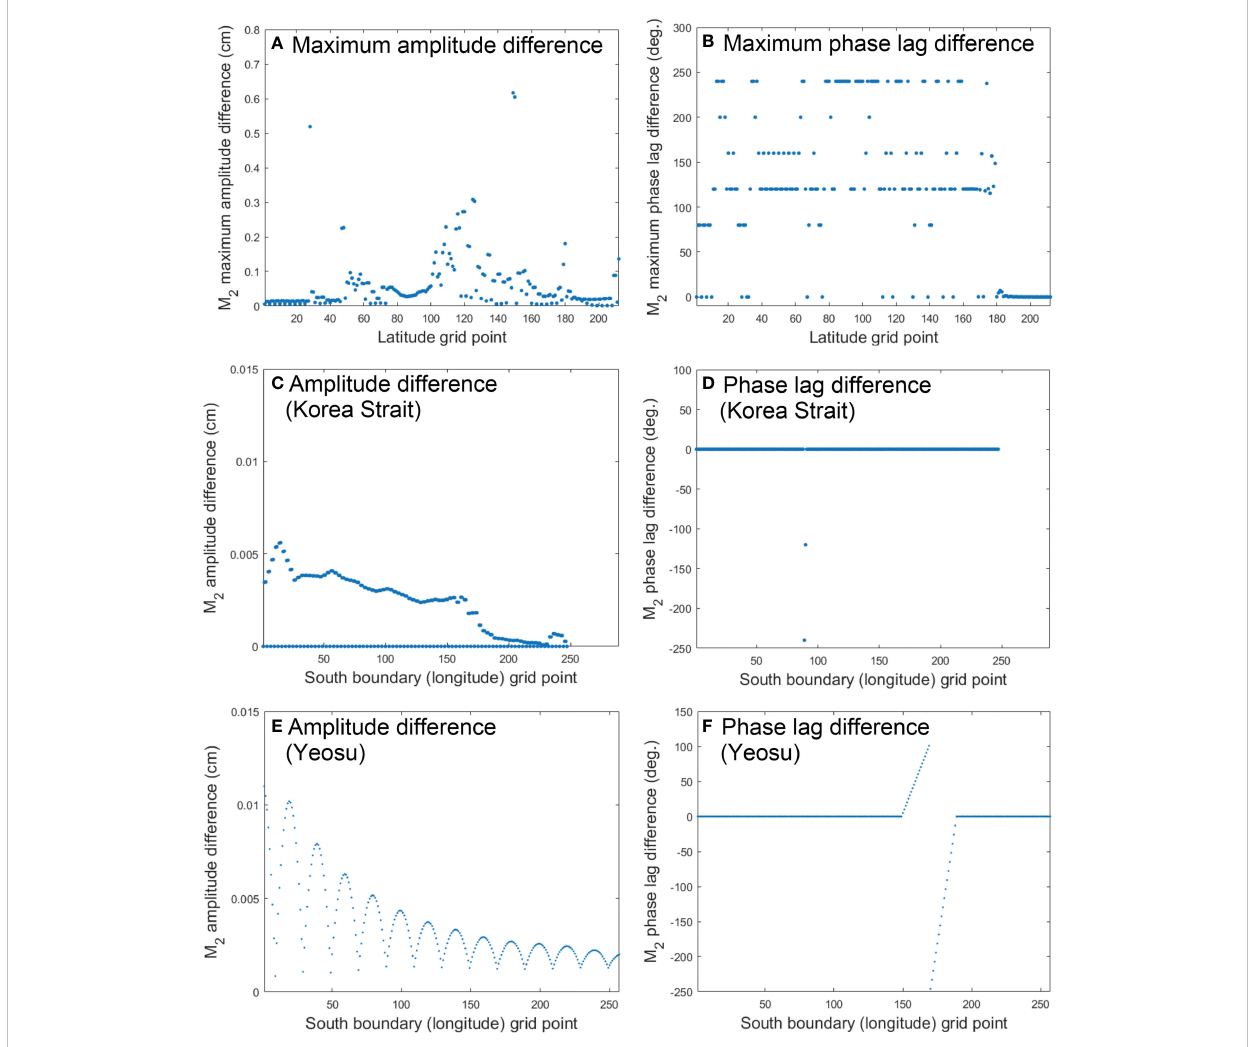
FIGURE 3 Maximum differences in amplitude and phase lag of the M 2 constituent (A, B) along longitudinal girds at each latitudinal grid point, derived from Figures 1E, F. Differences in amplitudes and phase lags along southern boundary of the Korea Strait domain (C, D) of Figure 1 and in the Yeosu coastal domain (E, F) of Figure